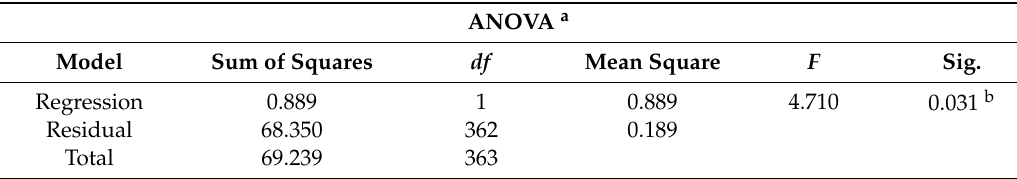
Table 4. Analysis of variance for textbook ownership and library visit.